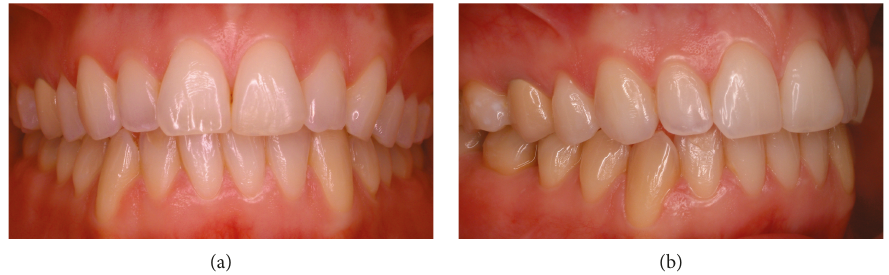
Figure 1: Preoperative intraoral frontal (a) and lateral (b) views showing the preexisting upper second premolar crown (tooth